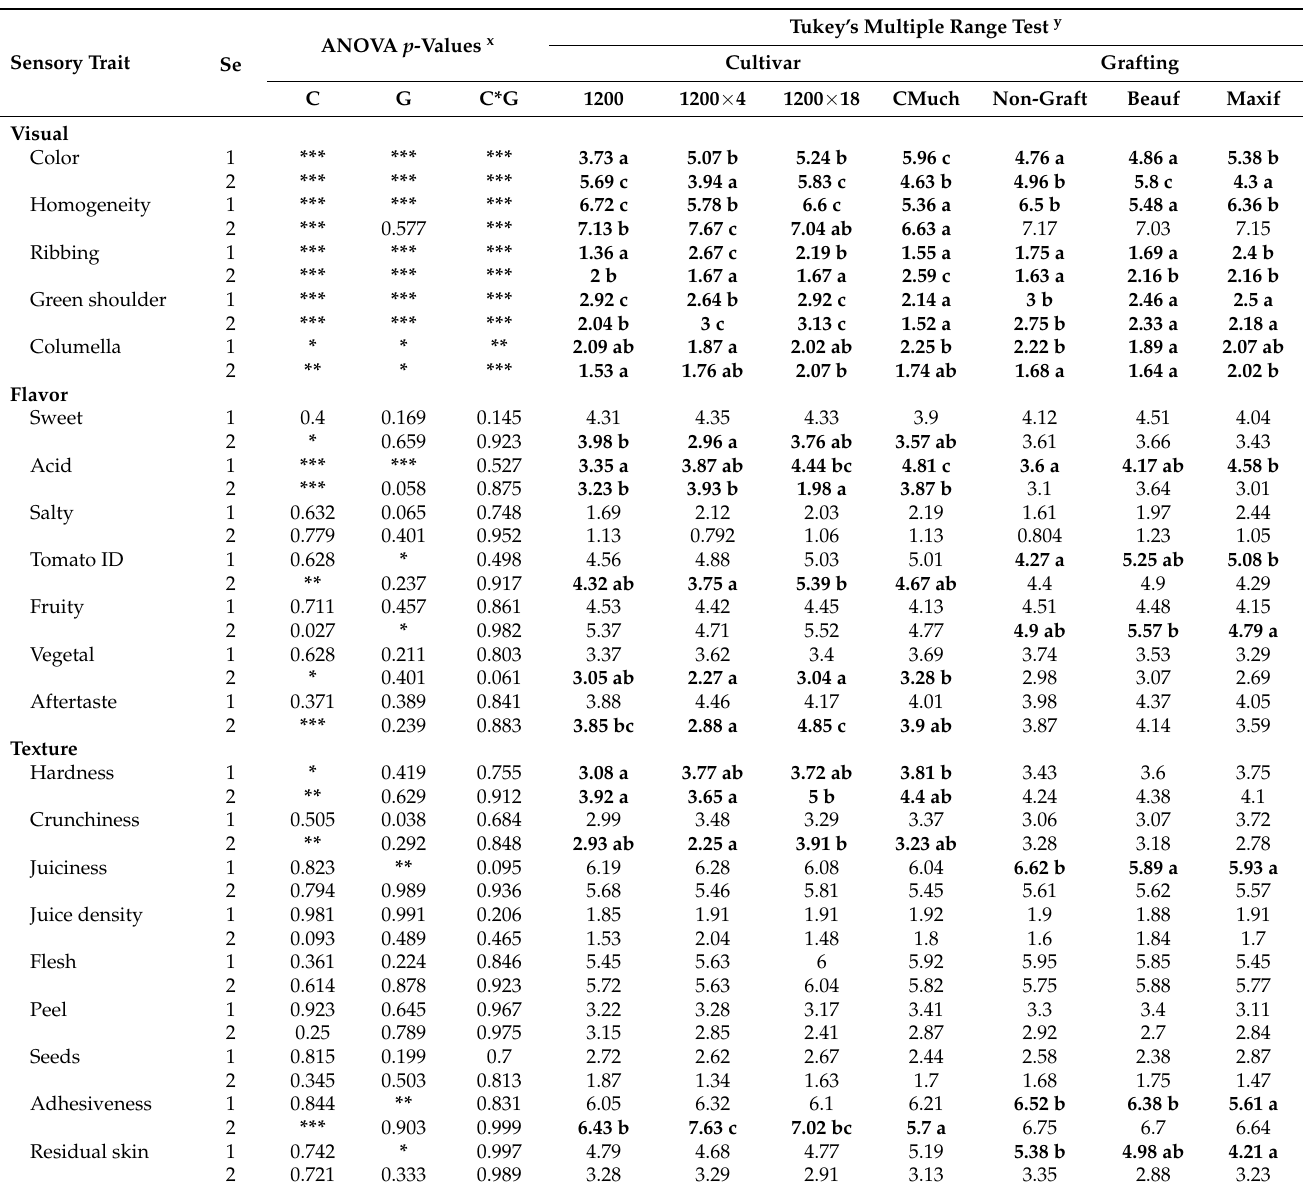
Table 4. Effect of grafting on sensory traits evaluated in CIAGRO-UMH trial (ANOVA and Tukey’s multiple-range test). Se: Session; C: Cultivar; G: Grafting; CMuch: Commercial Muchamiel. Bold format indicates statistical